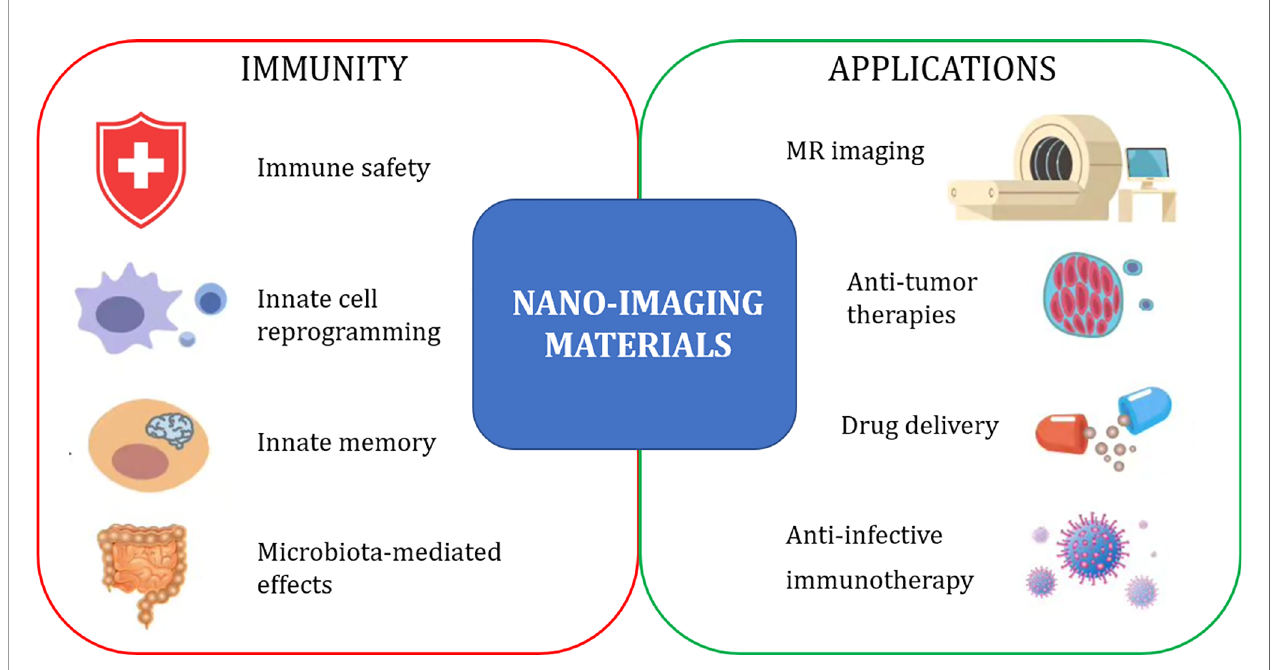
FIGURE 1 | Immunological effects and biomedical application of nano-imaging